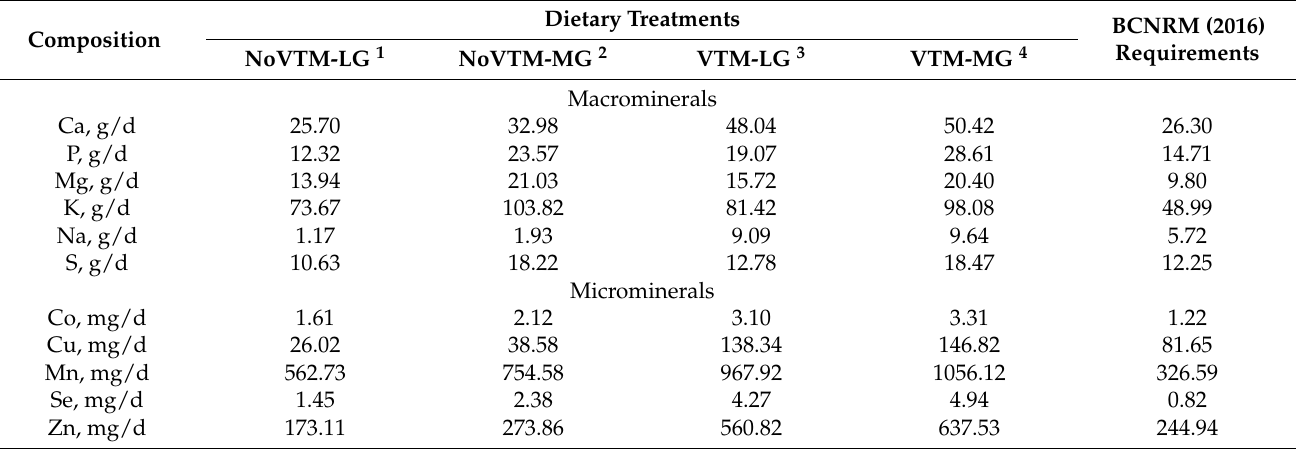
Table 3. Dietary intake of macro and trace minerals and values recommended by the BCNRM (2016; Nutrient Requirements of Beef